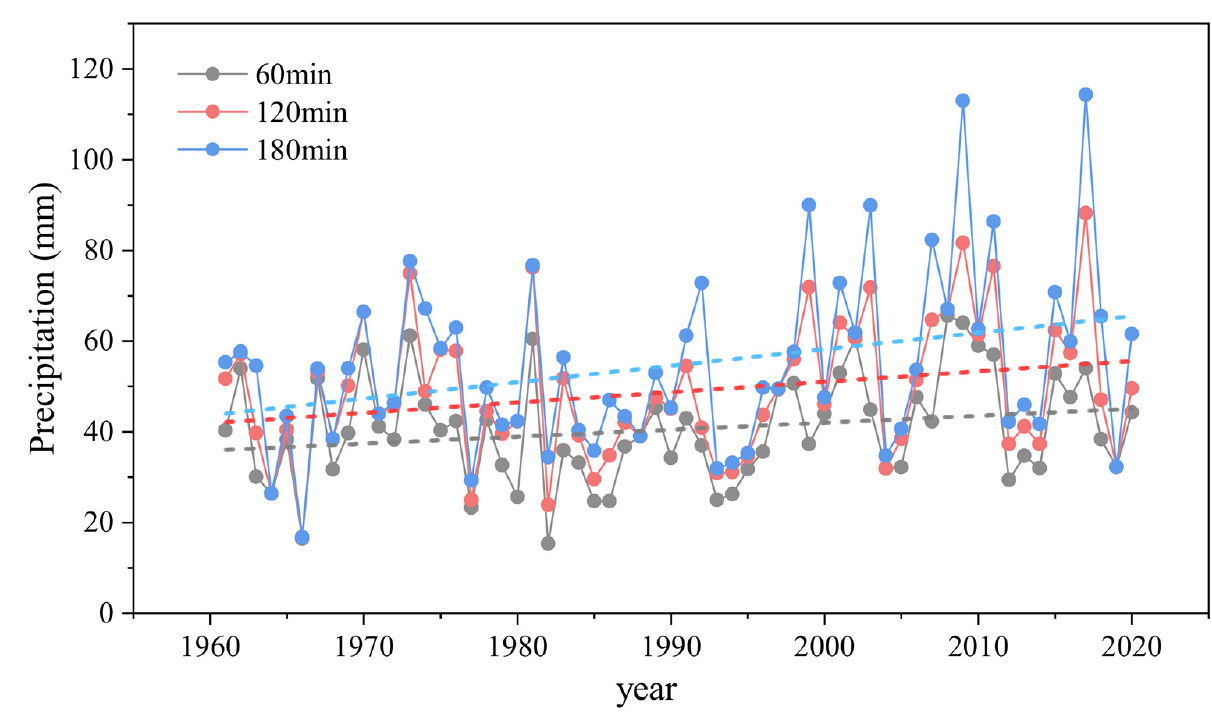
Figure 4. The linear trend of 60 min, 120 min, and 180 min maximum precipitation in Nanjing.